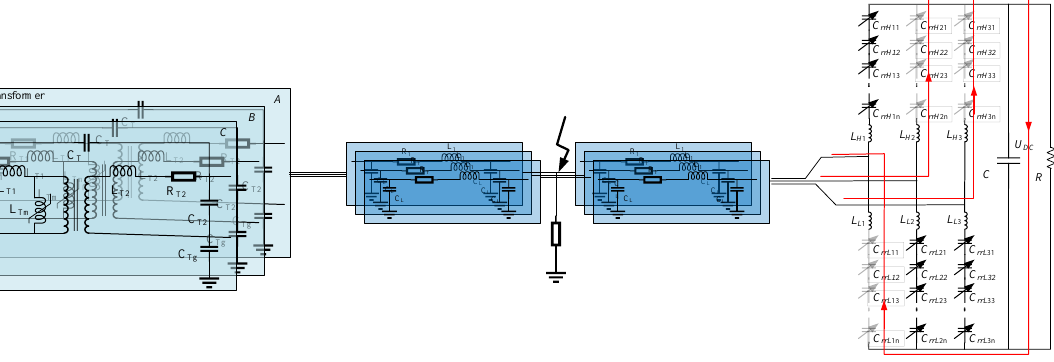
Figure 7. Transient physical model of lightning overvoltage for high-voltage diode